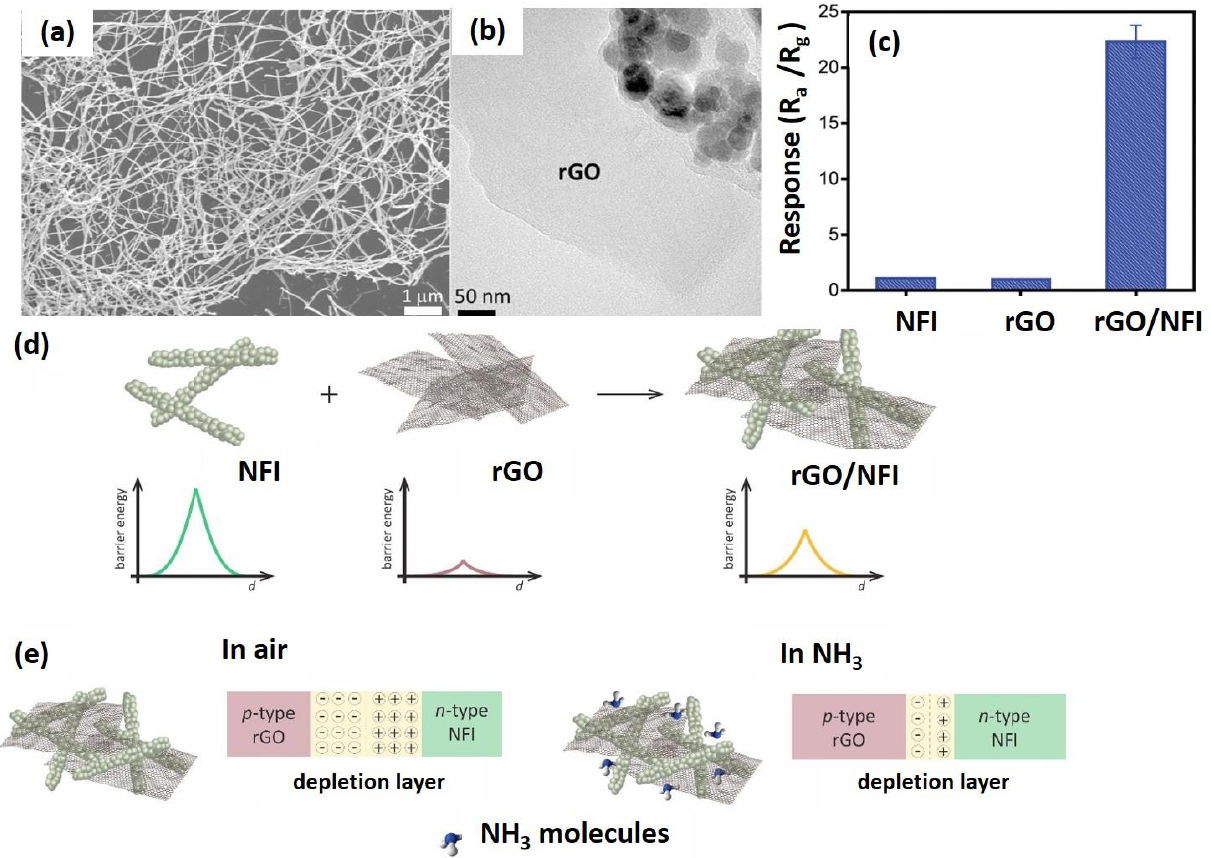
Figure 10. TEM image of ( a ) NFI, ( b ) rGO/NFI, ( c ) response of rGO/NFI exposure to 15 ppm NH 3 at room temperature, ( d ) schematic diagram of the potential barrier energy, and ( e ) configuration of the p-n heterojunction EDL of the hybrid rGO/NFI in the air and NH 3 atmosphere. Reproduced from ref. [155].